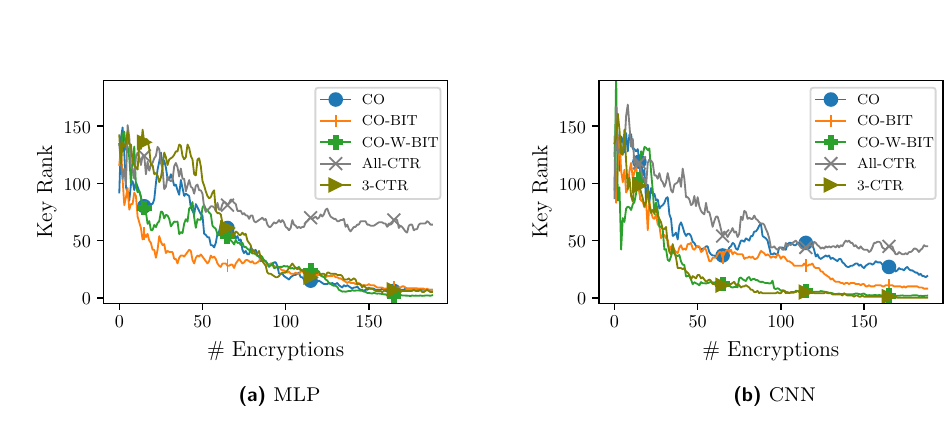
Figure 8: Attack results for the second